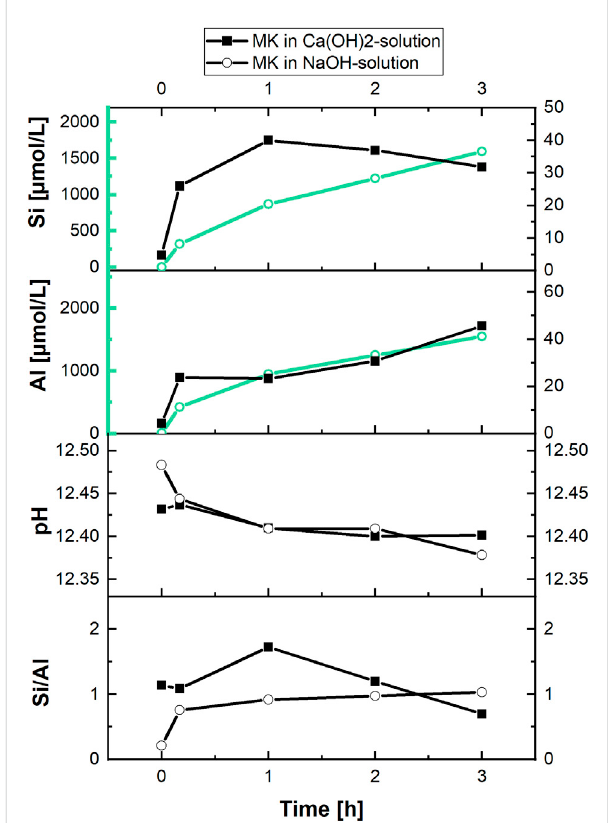
Silicate and aluminate concentrations as well as pH and Si/Al of the aqueous phase during reaction of MK in saturated Ca(OH) 2 — and NaOH-solution (both solutions: pH = 12.45, MK-dosage of 10.0